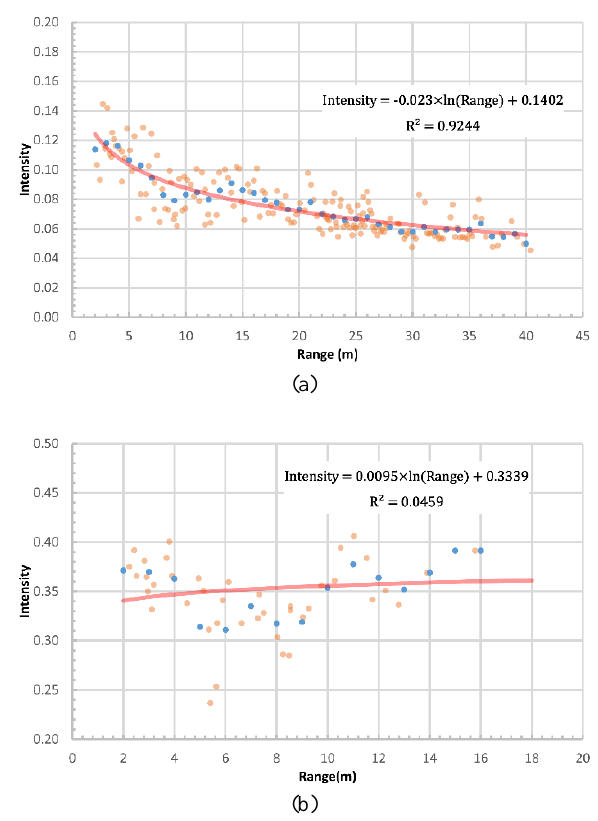
Figure 9. Correlation between range and intensity for points lying on: (a) pavement (asphalt); (b) road markings with a retroreflectivity reading between 140 and 150 mcd/lx/m 2 . Orange markers represent individual points and blue points represent the average for each 1 m range bin.